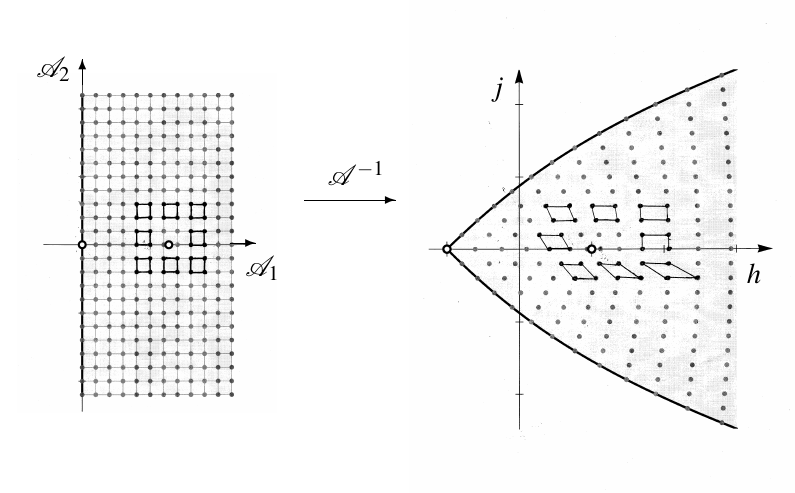
Figure 2. Using the shifting operators to show that the quantized spherical pendulum has monodromy.